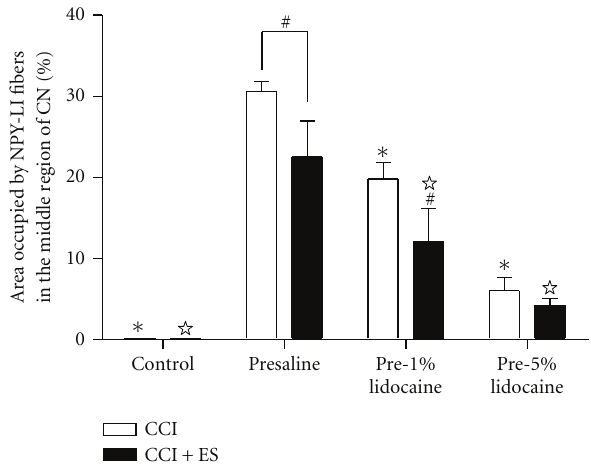
Figure 5: Histograms showing morphometric assessments used to quantify intensity of NPY-LI fibers in the middle CN at four weeks after chronic constriction injury without (CCI) or with electrical stimulation (CCI + ES). It is notable that the intensities of NPY-LI fibers in the CN were significantly lower in rats with electrical stimulation than those without stimulation in the presaline and pre-1% lidocaine groups 0 . 05 compared with unstimulated side in respective group). The intensity of NPY-LI fibers in the CN was also reduced by lidocaine ( # P (cid:0)